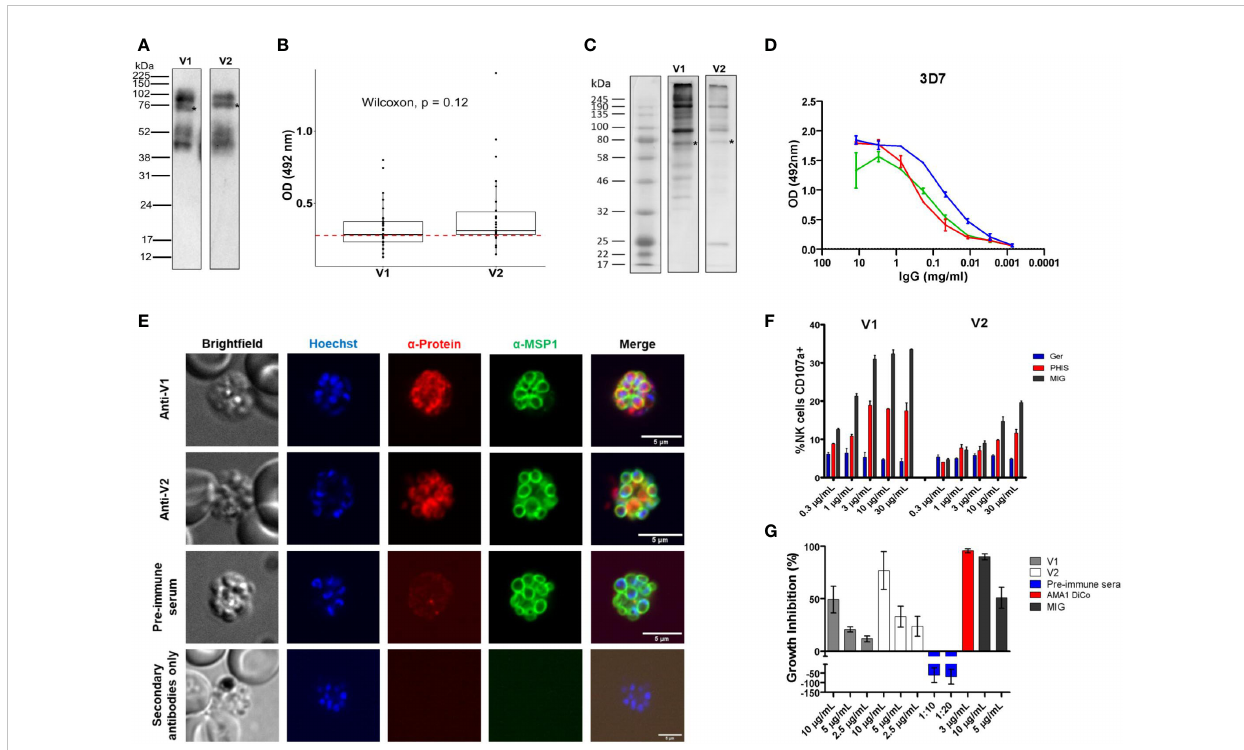
FIGURE 2 Subcellular localization of ARMA and induction of functional antibodies. (A) Western blot of recombinant proteins after puri fi cation. Four bands were detected using anti-histidine antibodies. Asterisks indicate the full-length proteins (75 KDa). (B) Immunogenicity of recombinant antigen variants V1 and V2 in Kenyan children ( n = 30). The red dotted line represents the threshold of seropositivity which was de fi ned as the mean of optic density (OD) + 2 standard deviations in malaria-naïve controls. (C) Merozoite extract western blot. Multiple bands were detected using rabbit antisera (primary antibodies) and anti-human antibodies (secondary antibodies). Asterisks show full-length proteins. (D) Merozoite ELISA using V1/V2 antisera shows speci fi c dose-dependent responses in the 3D7 strain. Antigen-speci fi c antibodies against apical membrane antigen 1 (AMA1) served as a positive control. (E) Immuno fl uorescent staining showing the colocalization of ARMA with MSP1 on the merozoite surface. Late schizont stages were double stained with rabbit antisera (anti-V1 or anti-V2) and mouse anti-MSP1 (full-length) in immuno fl uorescence assay. Rabbit preimmune sera were used to assess non-speci fi c binding. The merozoite nuclei were stained with Hoechst. Incubation of parasites with only anti-rabbit antibodies excluded non-speci fi c binding of secondary reagents. (F) Dose-dependent NK cell degranulation with antibodies against variants V1 and V2. Ger: Malaria-naive serum from German donors. (G) Dose-dependent growth inhibition activities of rabbit anti-sera (anti-V1 and anti-V2) in three independent assays. Rabbit preimmune sera, anti-AMA1 DiCo and MIG were used as